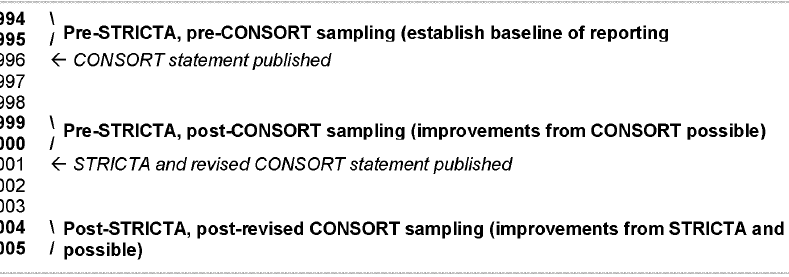
Figure 1. Rationale for time periods of study selection.